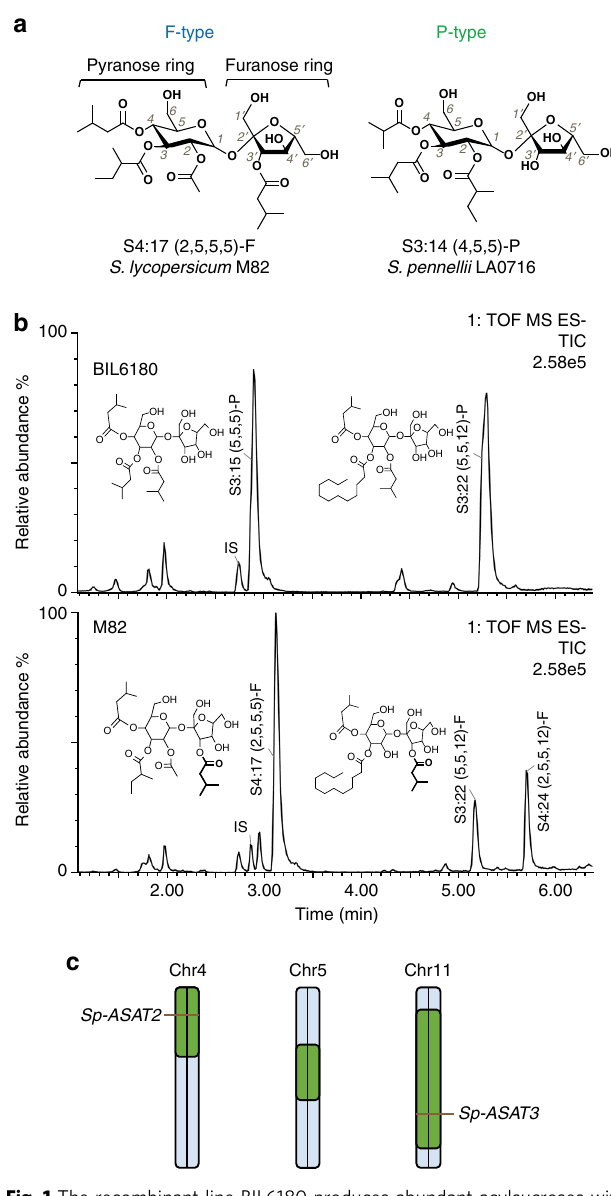
Fig. 1 The recombinant line BIL6180 produces abundant acylsucroses with all acyl chains on the pyranose ring. a Structures of representative F- and P- type acylsucroses puri fi ed from S. lycopersicum M82 and S. pennellii LA0716, respectively. The F-type acylsucrose has acylations on the pyranose and furanose rings, with a single acyl chain at R 3 ′ position. The P-type acylsucrose has three acyl chains on the pyranose ring, with no furanose ring acylation. b BIL6180 produces abundant P-type acylsucroses, while S. lycopersicum M82 accumulates mainly tri- and tetra- F-type acylsucroses in the trichomes. IS: internal standard. The two total ion chromatograms are scaled to the same intensity, where the major peak (S4:17-F) in M82 has the maximum signal (100% scale). c BIL6180 has three chromosome regions from S. pennellii (green) introgressed into S. lycopersicum M82 background (blue). The introgressions on chromosomes 4 and 11 include Sp-ASAT2 and Sp-ASAT3 ,